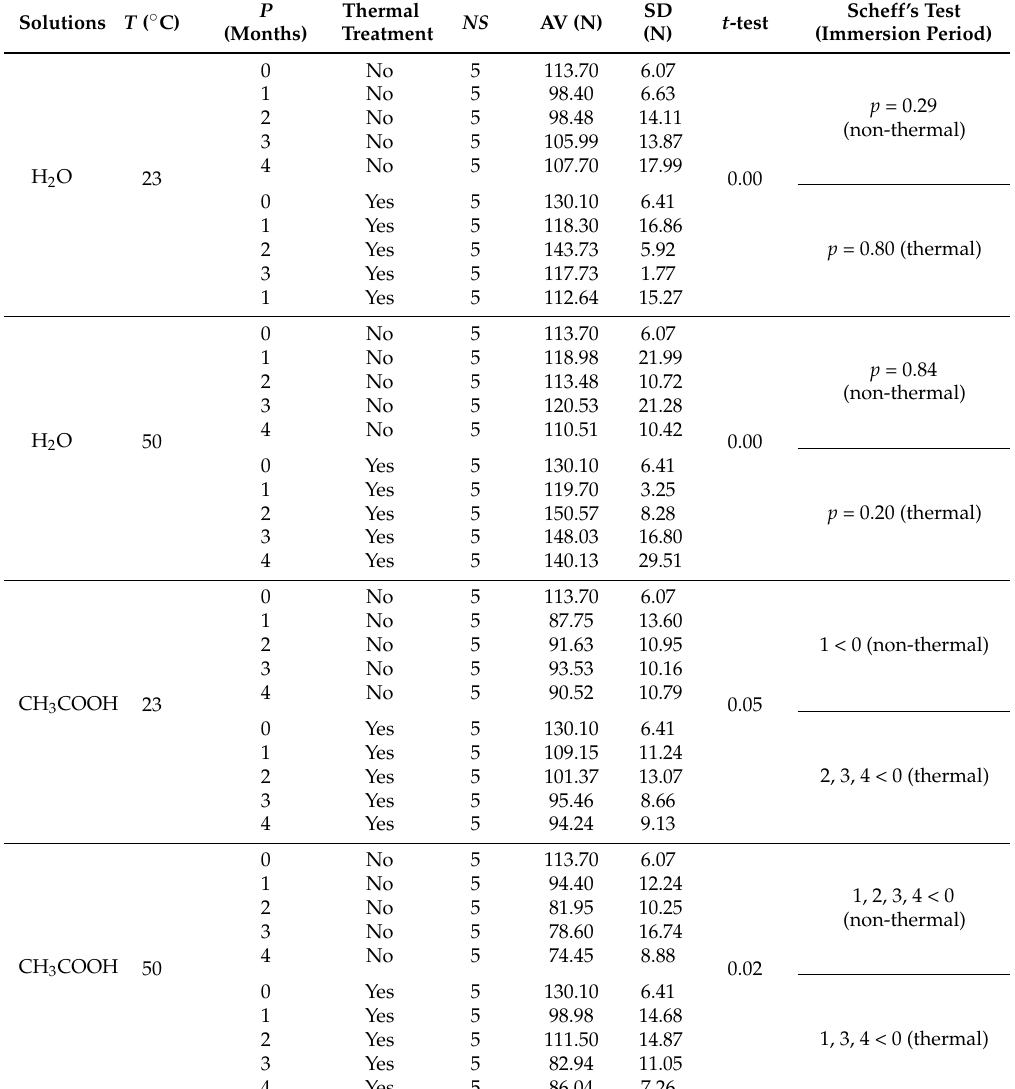
Table 4. Tensile strength and statistical analyses of recycled Kevlar ® /PET/LPET nonwoven geotextile that are thermally treated, in relation to different solutions and different immersion